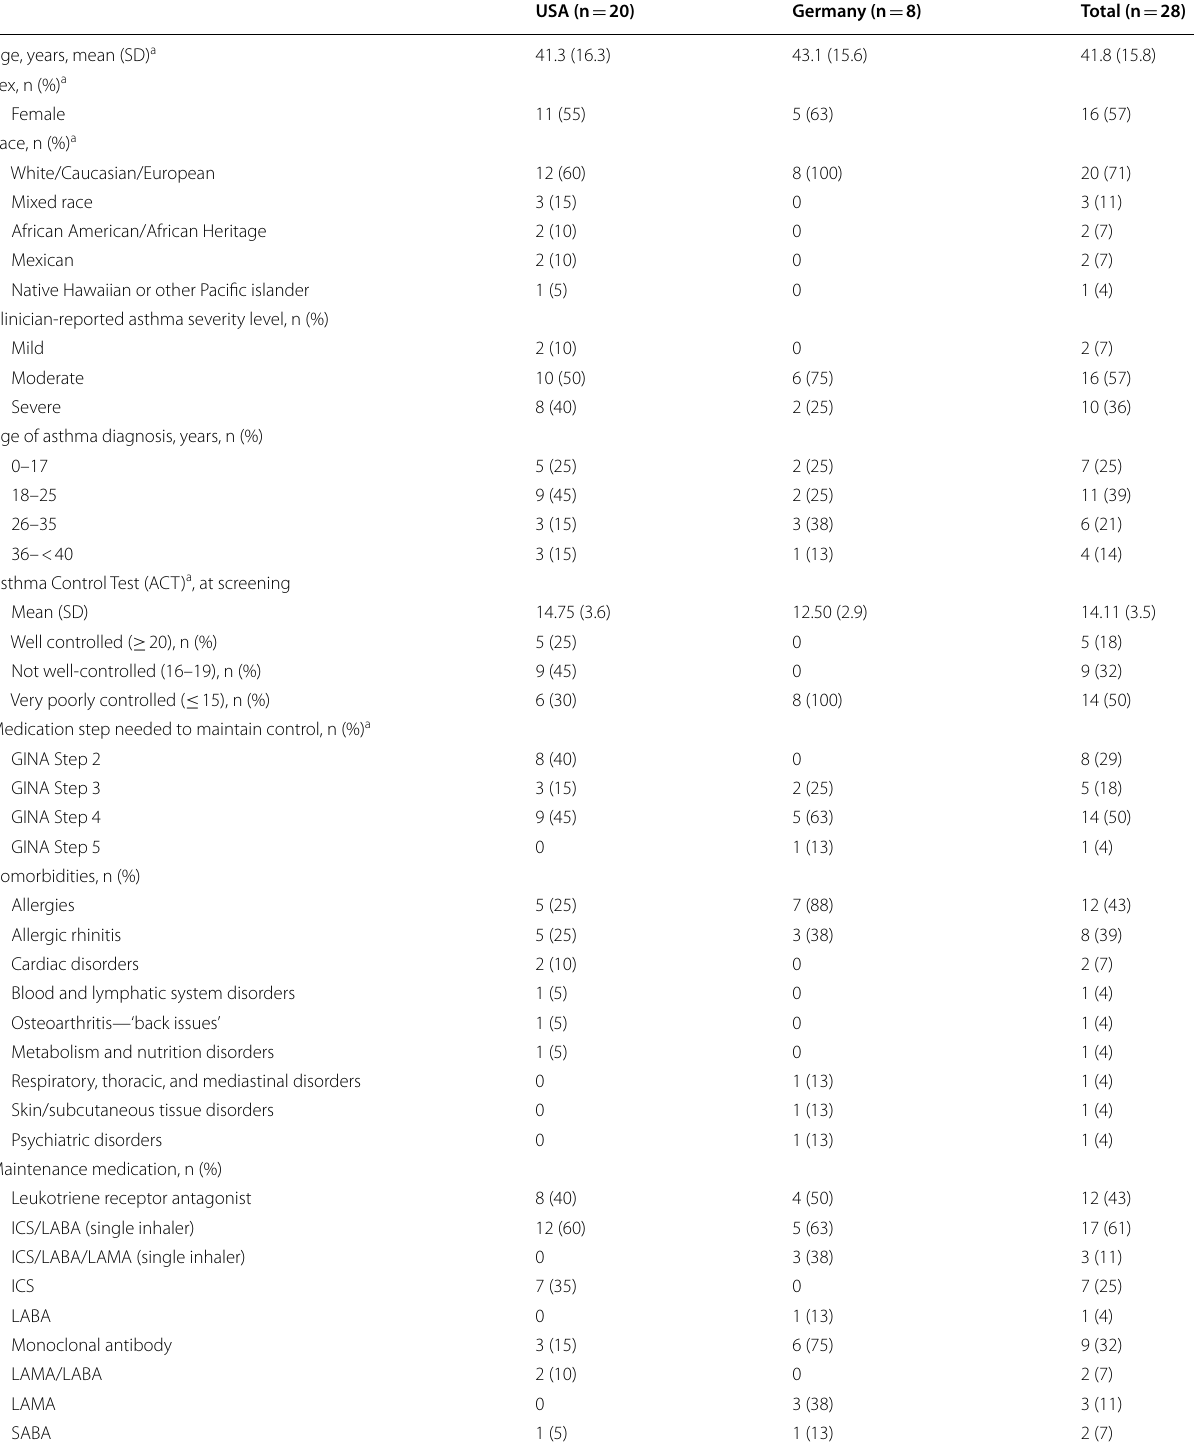
Table 1 Patient sociodemographic and clinical